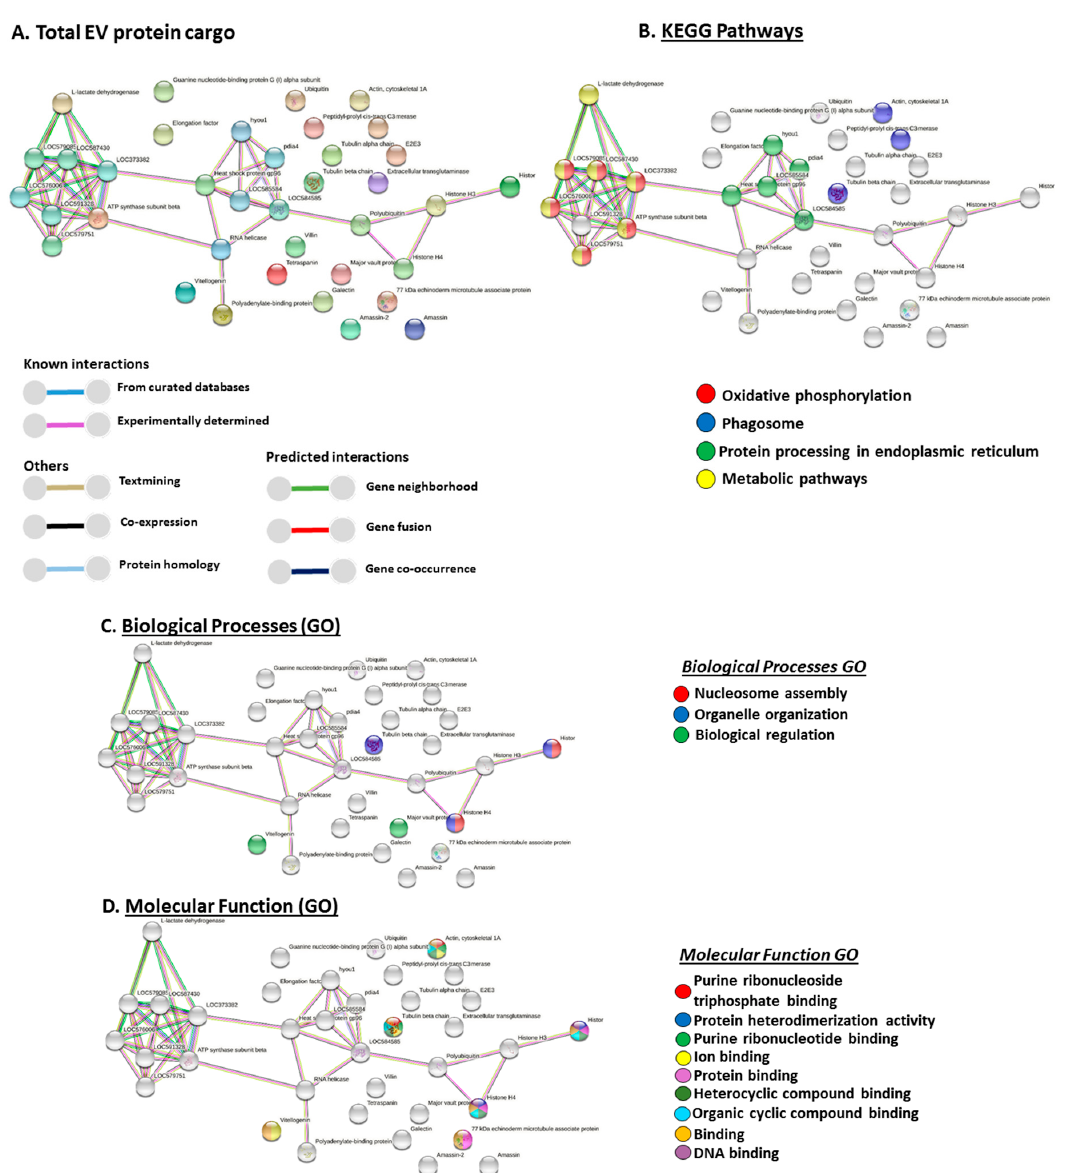
Figure 2. Protein–protein interaction networks of total EV protein cargo identified in purple sea urchin. ( A ) Functional protein networks are based on known and predicted interactions in Echinoidea using STRING analysis. Coloured nodes represent query proteins only. Coloured lines connecting nodes show the type of interactions between the nodes of the networks based on known interactions, predicted interactions, and others (including text ‐ mining, co ‐ expression, and protein homologue); colour code legend is provided in the figure. PPI enrichment p ‐ value for the protein network is 9.25 × 10 − 5 . ( B ) KEGG pathways identified from STRING analysis for EV total protein cargo (annotated hits). ( C ) Gene Ontology (GO) Biological processes identified from STRING analysis for total EV protein cargo (annotated hits). ( D ) GO Molecular Function pathways identified from STRING analysis for total EV protein cargo (annotated hits; protein names of hits are presented in the figures; additional interacting proteins are: LOC579085 = ATP synthase subunit gamma, mitochondrial; LOC587430 = ATP synthase subunit O, mitochondrial; LOC373382 = ATP synthase subunit alpha; LOC576006 = ATP synthase subunit delta, mitochondrial; LOC579751 = ATP synthase F(0) complex subunit B1, mitochondrial). EVs For the detection of a putative PAD homologue from sea urchins, anti ‐ human PAD2 ‐ specific antibody was used in Western blotting to assess any cross ‐ reaction with a